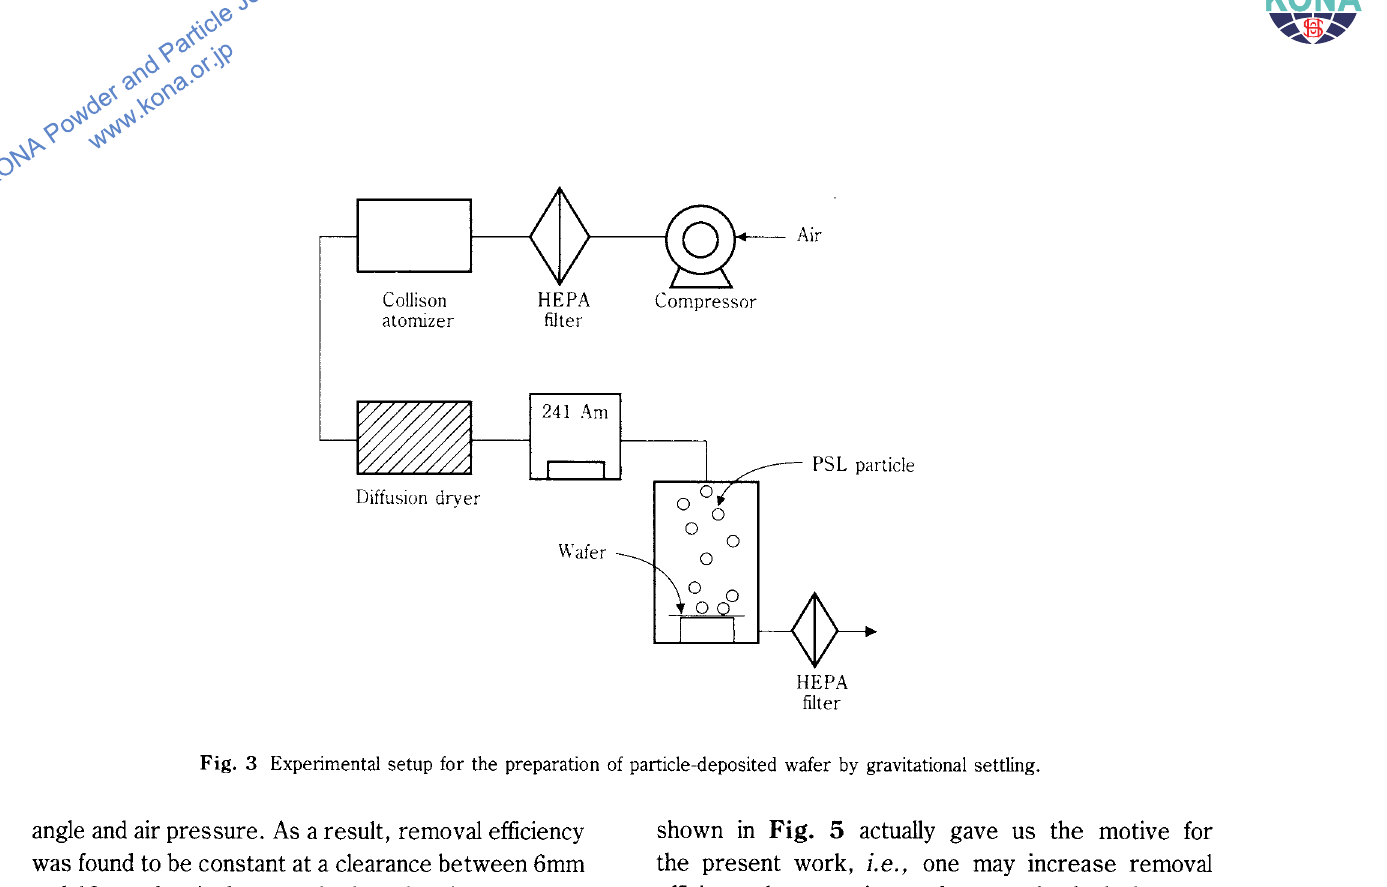
Fig. 4 Influence of nozzle angle on removal efficiency.